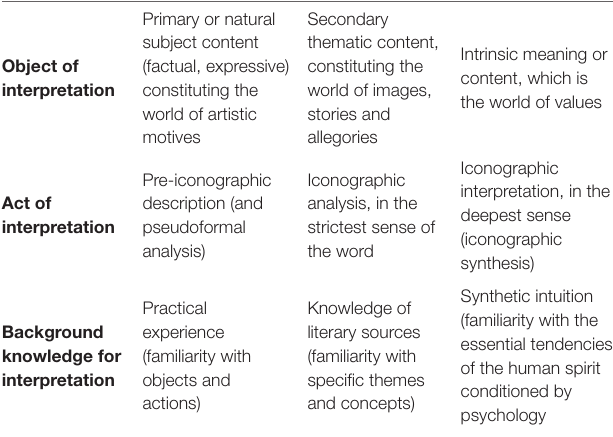
TABLE 1 | Adaptation of Panofsky’s Synoptic Table on image